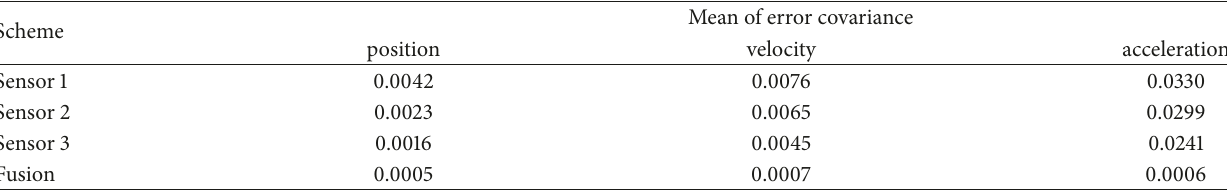
Table 2: Comparison of mean square